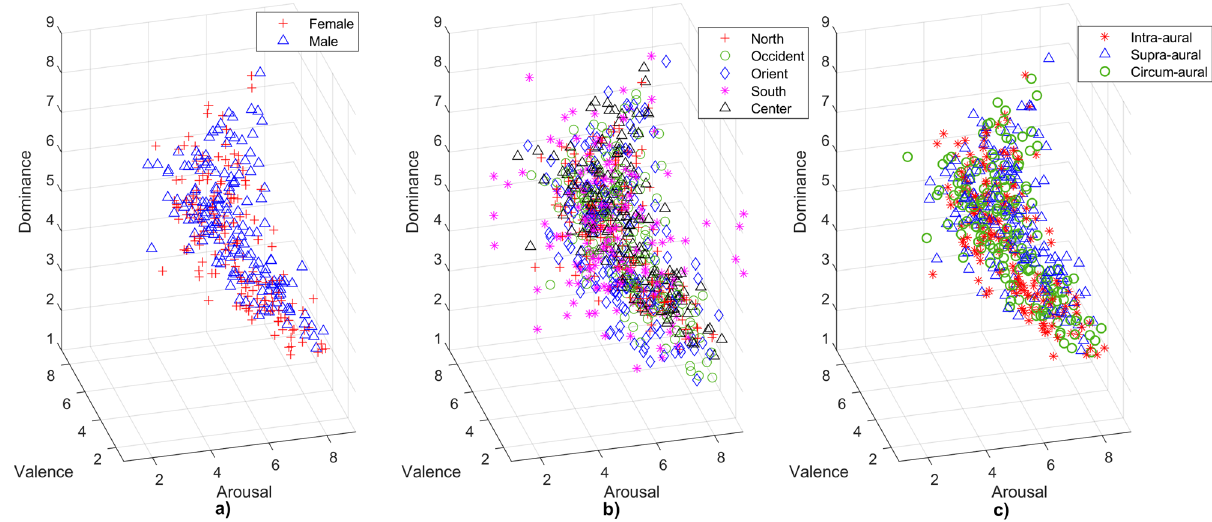
Figure 4. Distribution of mean ratings in the VAD model for MEX. Each plot presents 167 data points representing the mean rating of participants in SAM for each IADS-2 sound. The marker type indicates the group in each category. The 329 ratings were divided within each category as follows: ( a ) Sex group (N: female = 143, male = 186). ( b ) Regions (N: north = 115, occident = 41, orient = 36, south = 13, center = 124). ( c ) Type